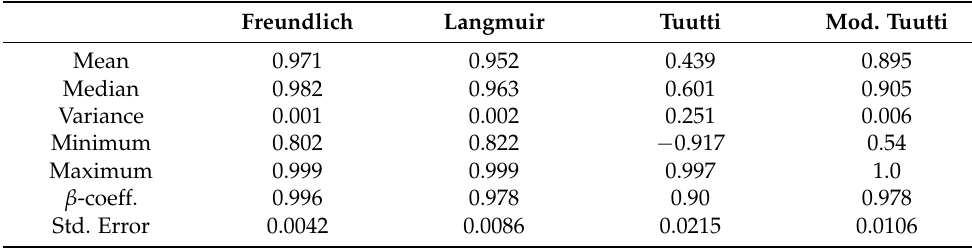
Table 5. Descriptive analysis of the Coefficient of Determination for the data gathered from the literature as well as the data in this